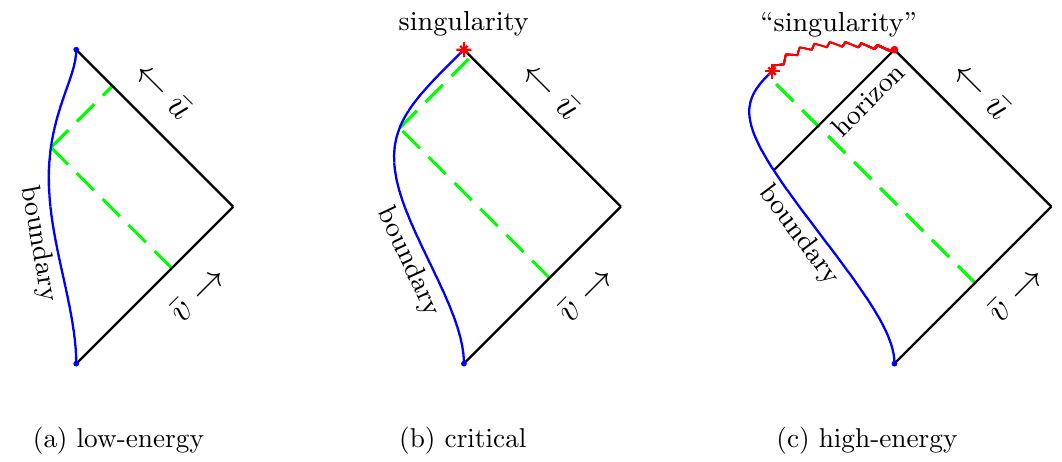
Figure 2 . The simplest exact solution ( s 1 = s 2 = 1) in the model with a boundary at di(cid:11)erent values of parameters. Finite-range light-cone coordinates ((cid:22) u; (cid:22) v ) are used. The centers of the incoming and re(cid:13)ected matter wave packets are marked by the dashed